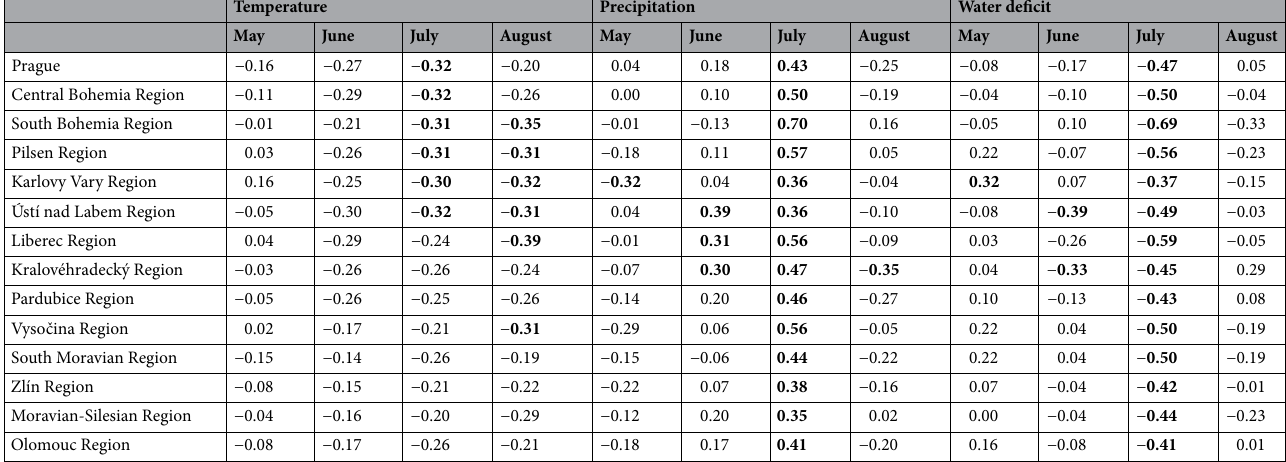
Table 3. Pearson correlation between silage maize yield rate with temperature, precipitation, and water deficit in all